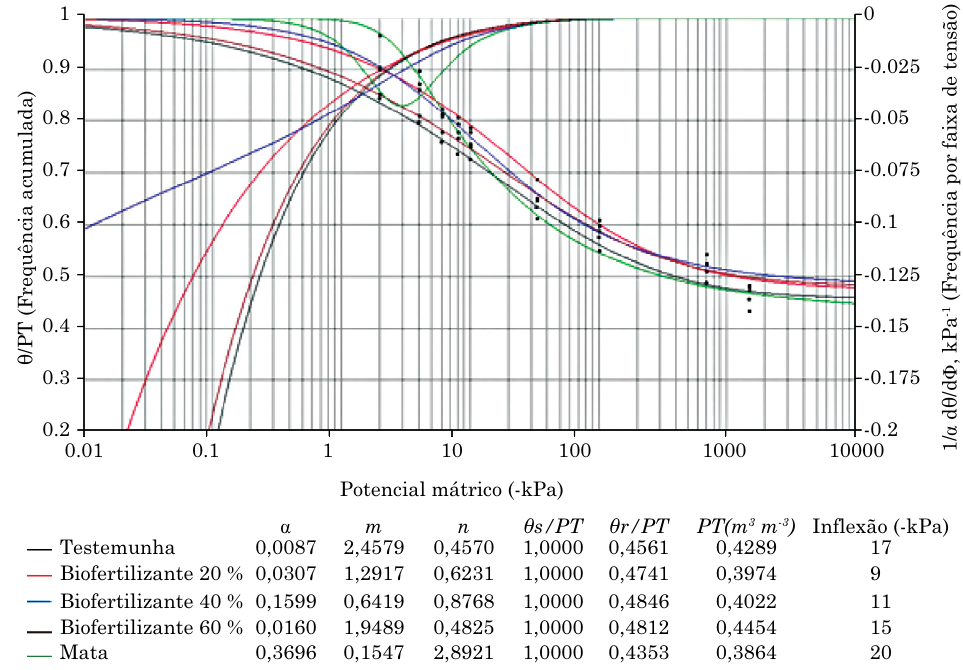
Figura 8. curva característica de água no solo e curva diferencial da curva característica de água no solo para as áreas sob cultivo de figo e mata secundária na camada de 0,2-0,3